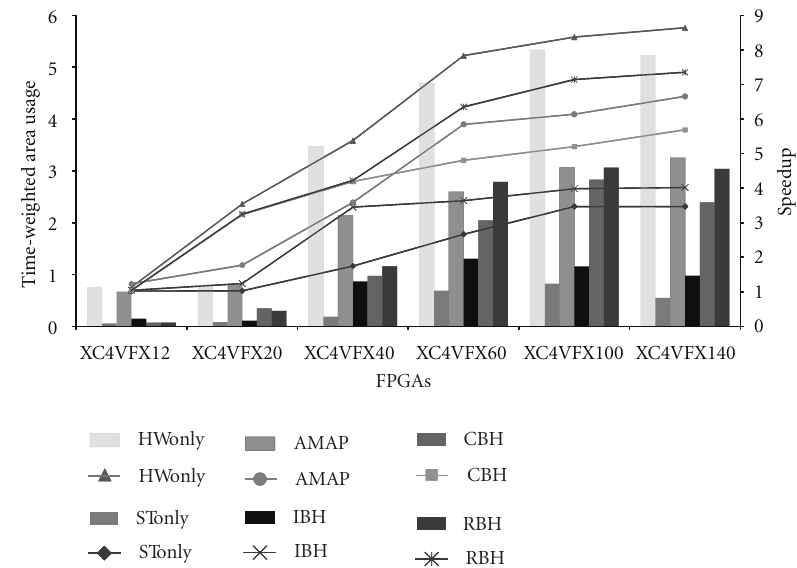
Figure 8: The comparison of di ff erent heuristics in terms of time-weighted area usage against speedup under di ff erent FPGAs conditions. The HWonly has the most time-weighted area usage, followed by the other runtime heuristics AMAP, CBH, IBH, and RBH.